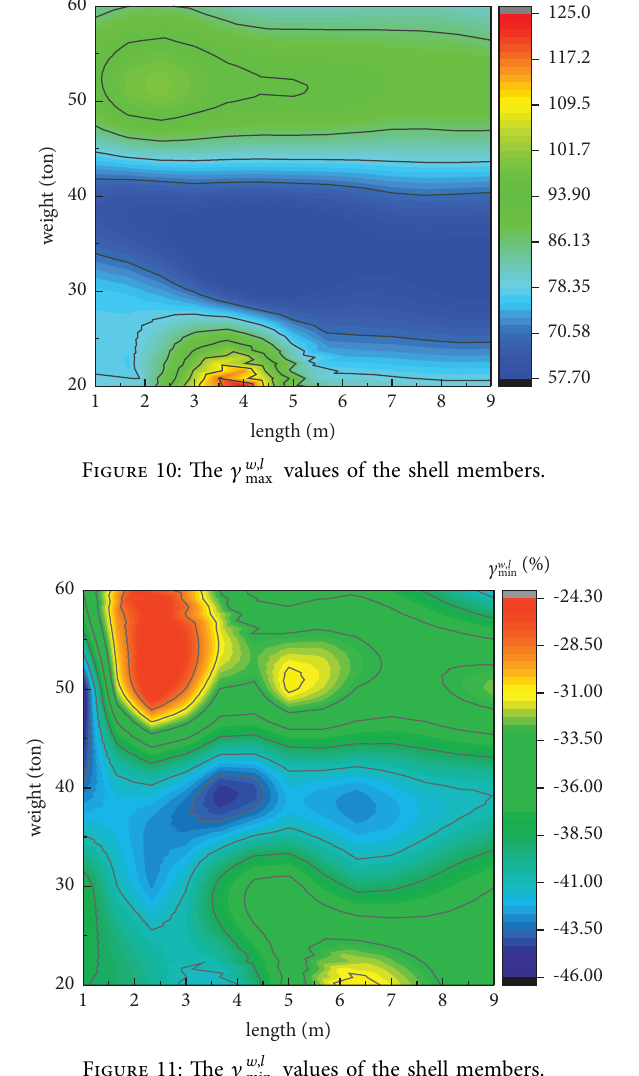
values of the shell min